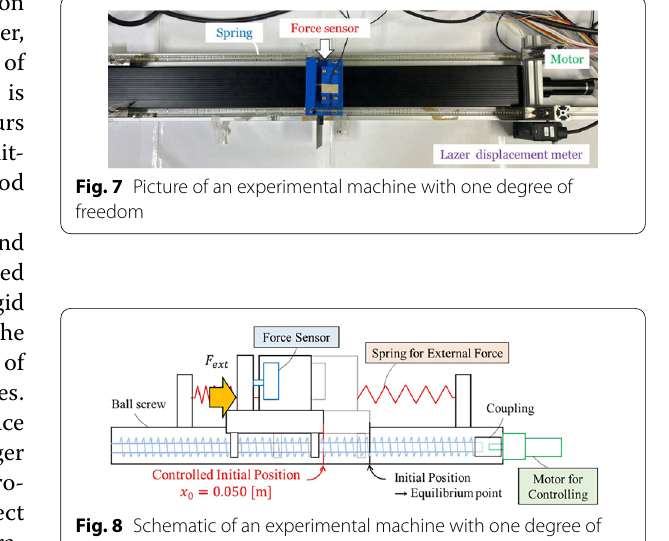
k e 6.25, 100 ˆ = arranged, the total spring constant is k e